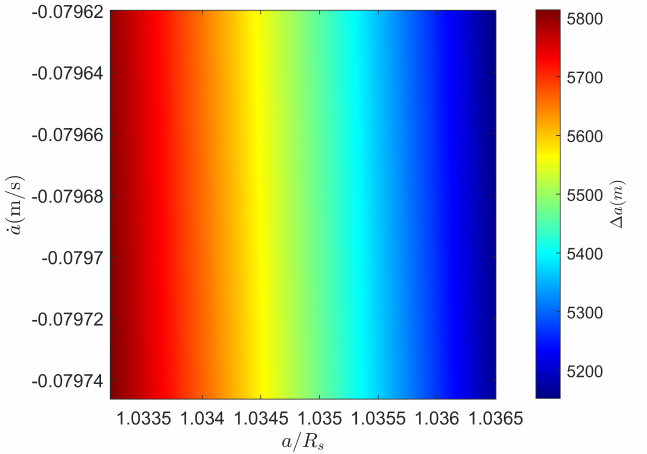
Figure 7. The semimajor aixs compensation ∆ a (m) for repeating ground track orbits where a ∈ [ 62,268, 62,468 ] km.